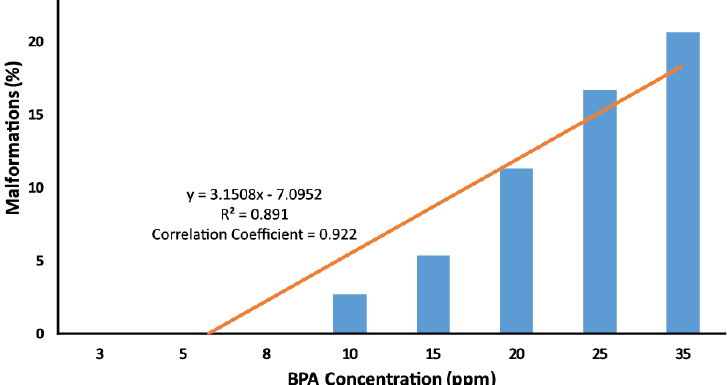
Figure 3. Digital photos from Artemia franciscana nauplii ( A ). Unaffected nauplius ( B ). Nauplius with obvious structural abnormality on the naupliar eye after 72 hours of exposure to BPA ( C ). Comparative image of an A. franciscana individual after 72 hours of exposure in BPA and unaffected individuals.